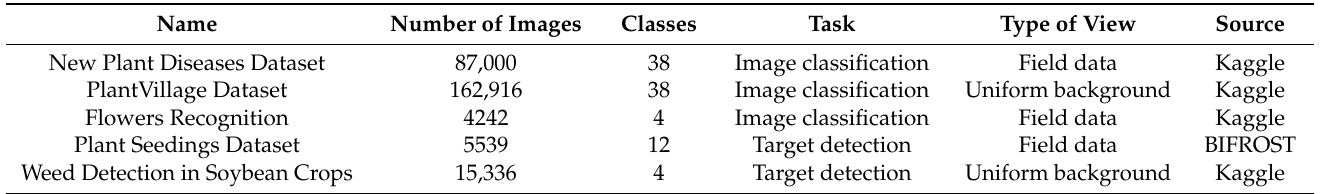
Table 2. Some public plant datasets from Kaggle and BIFROST.